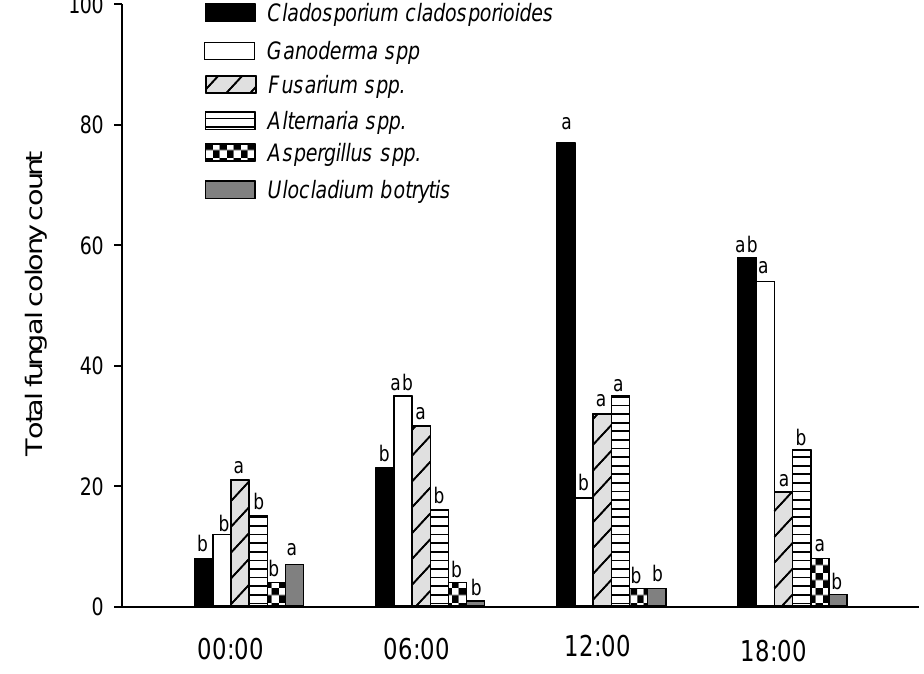
Figure 4. Diurnal variations in total fungal colony counts of the most common species in the atmosphere of Doha during the period 1 February to 31 March 2016. A total of 72 exposure samplings. Within each fungal taxa, values with common letters are not significantly different at p ≤ 0.05, according to Tukey’s test. Significant correlations were reported between mean daily temperature and the mean daily counts of Alternaria spp. ( r = 0.316) and mean daily counts of Ganoderma spp. ( r = 0.237) at p ≤ 0.05, according to Pearson’s correlation